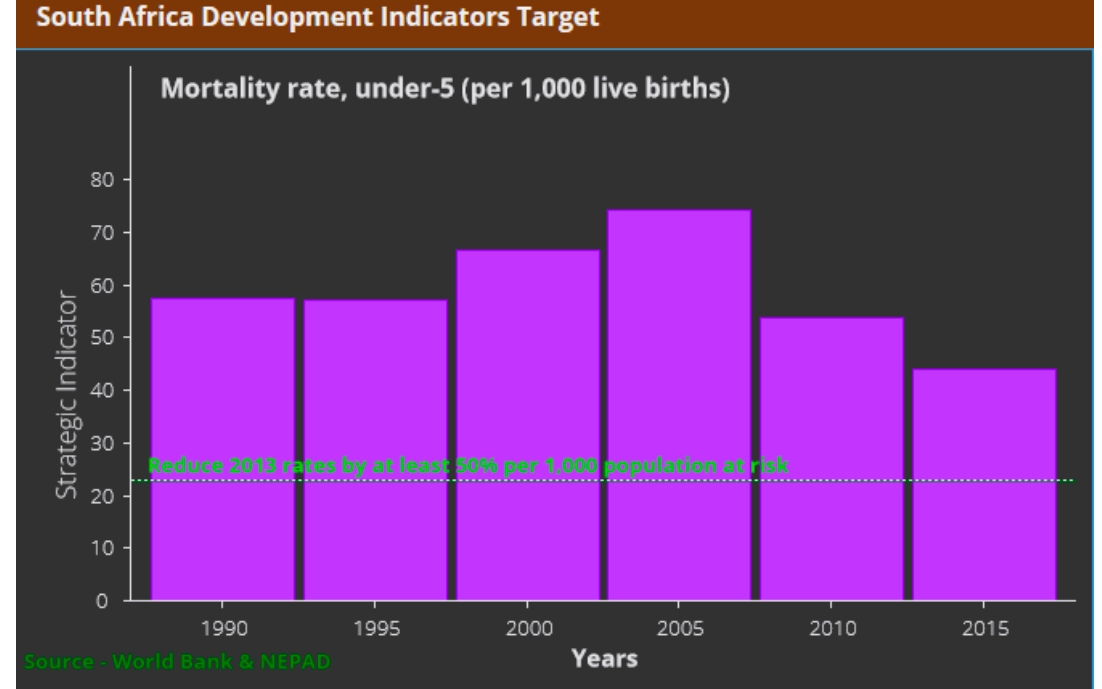
Figure 15. Mortality rate information displayed by the front end.